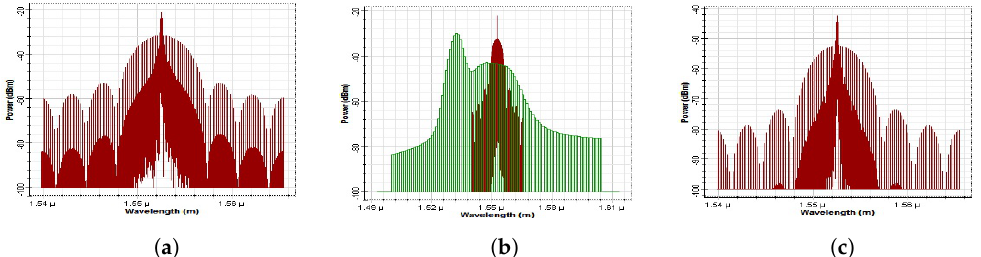
Figure 11. Optical spectrum analyzer; ( a ) input transmitted signal for 1st channel, ( b ) without managing NLIs, LDs and PAPR at 10 km of fiber length, ( c ) output signals with managed of NLIs, LDs and PAPR at 10 km of